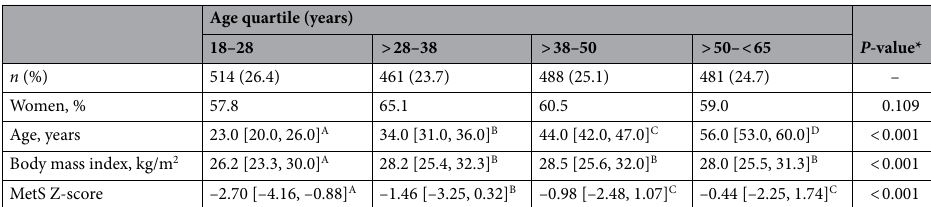
Table 3. Characteristics of the subjects by age quartile. Values are frequency (percentage), percentage, or median [25th percentile, 75th percentile]. *Pearson Chi-Square, or Independent-samples Kruskal–Wallis. Different superscripts indicate differences between groups in the pairwise post-hoc tests ( P -value <